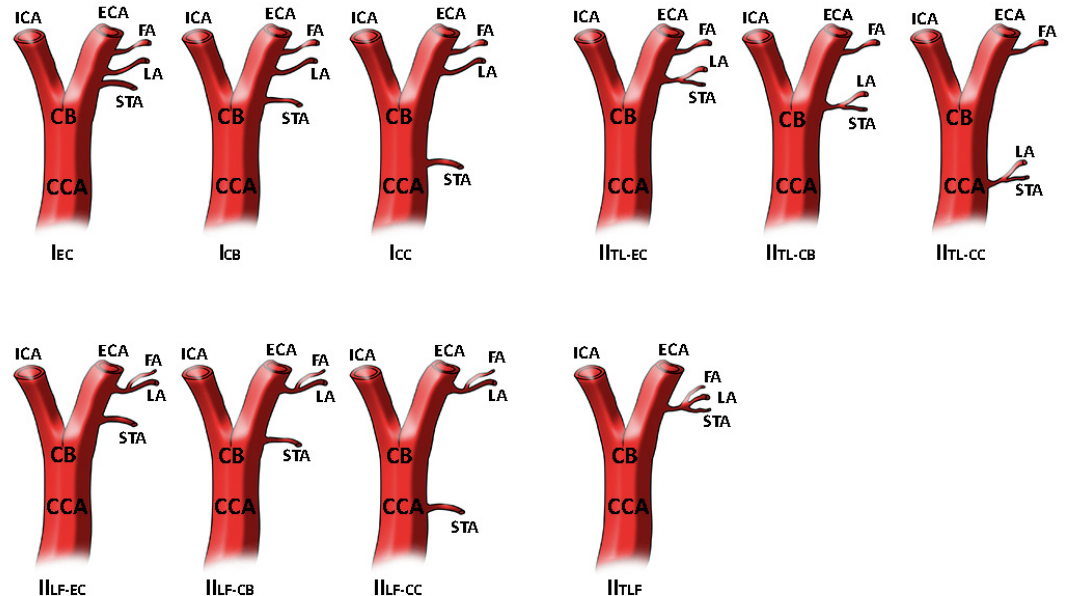
Figure 1. STA different origin as reported and modified by Natsis and colleagues. In type I STA origins as separate branch at different levels. In type II STA is a part of thyrolingual trunk or